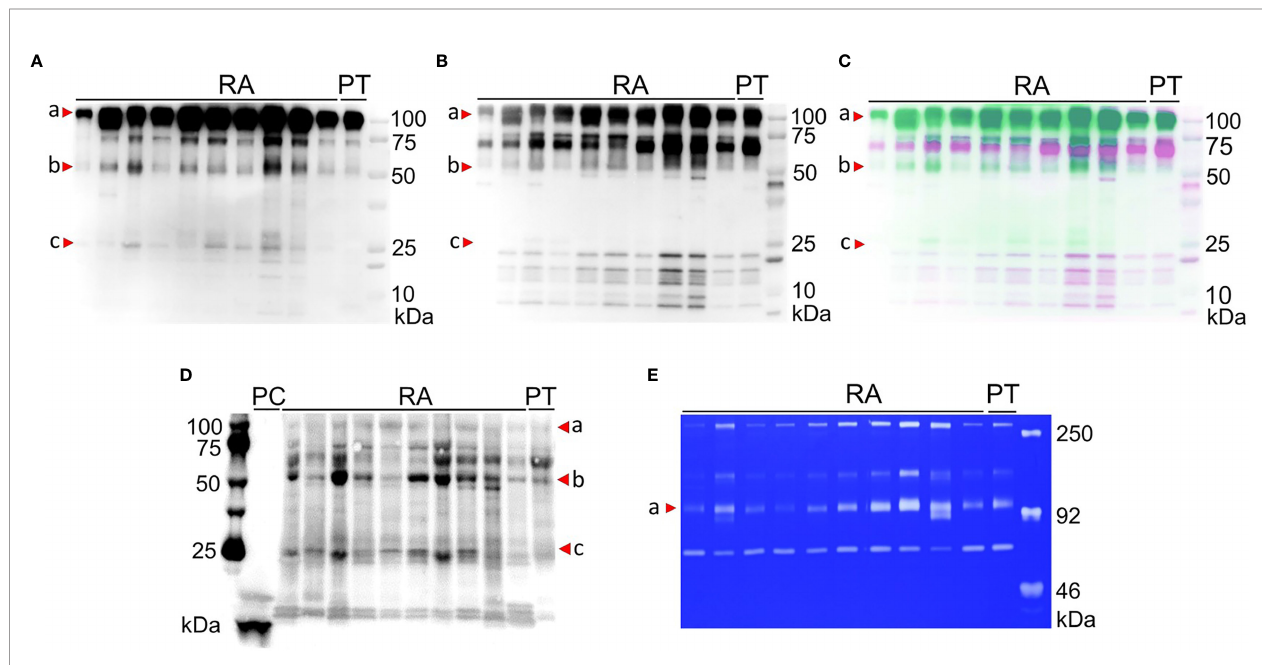
FIGURE 3 | Citrullinated MMP-9 proteoforms are detected in arthritic synovial fl uids. Western blots of synovial fl uids of 10 rheumatoid arthritis (RA) and 1 post trauma (PT) patient were probed for MMP-9 (A) and its hemopexin domain (B) . False-colour overlay of image (A) (green) and (B) (purple) revealed uniquely green 57 kDa bands (b), thus representing hemopexin-less MMP-9, whereas degraded hemopexin fragments (c) appear purple (C) . We identi fi ed intact MMP-9 (a) and citrullinated MMP-9 proteoforms at 57 kDa (b) and 25 kDa (c) by modi fi ed citrulline detection. Citrullinated CXCL8 was positive control (PC) (D) . Zymographic analysis showed differential levels of MMP-2 and MMP-9 proteoforms in crude synovial fl uids (E)